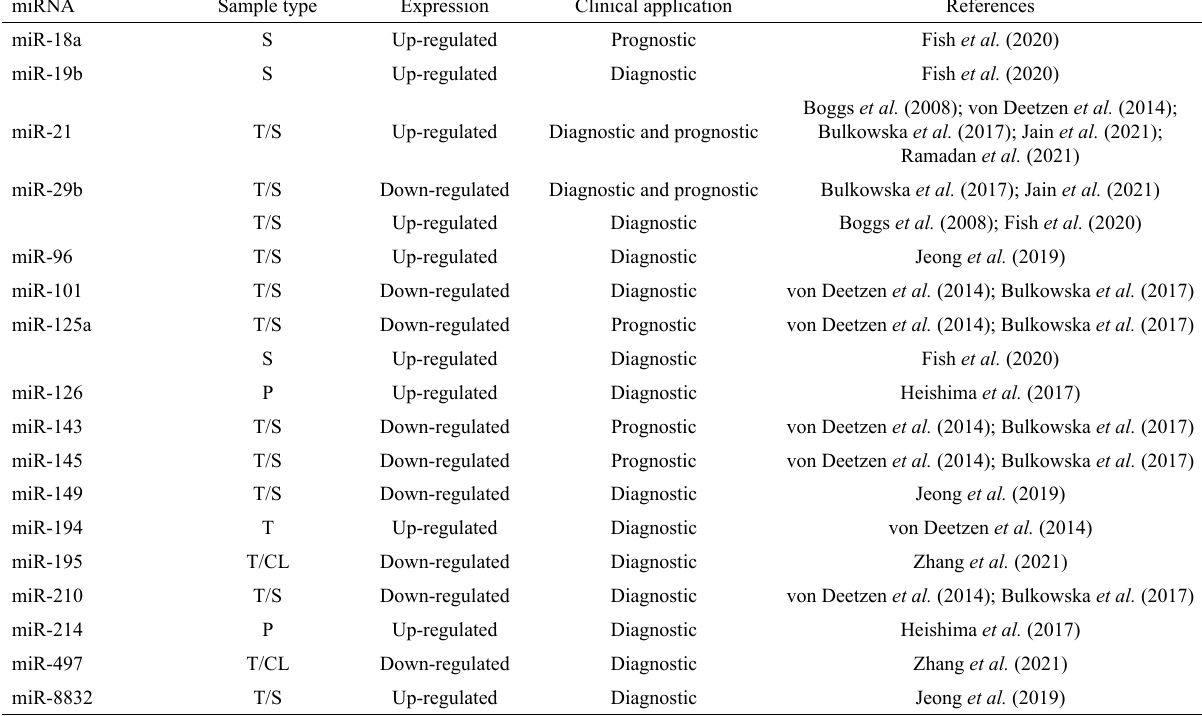
Table 1 – miRNA expression pattern in clinical samples of canine mammary cancer and their possible application on veterinary routine. CL= cell line; P= plasma; S= serum; T= mammary tissue.